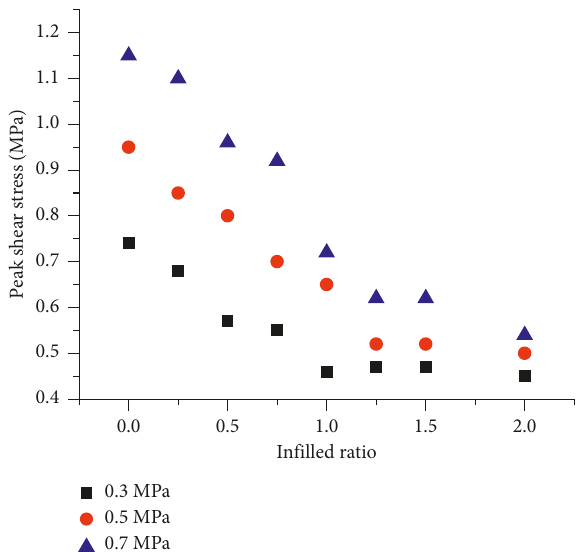
Figure 10: Shear stress peak evolution with different infill